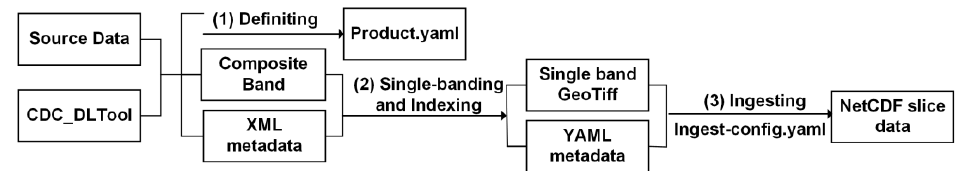
Figure 2. Workflow of loading Chinese satellite imagery data based on CDC_DLTool.